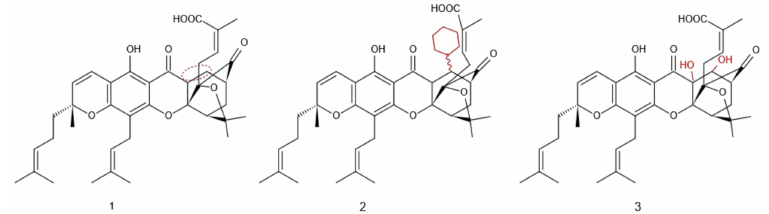
Figure 3. Structure of Gambogic acid derivatives at C9-C10.